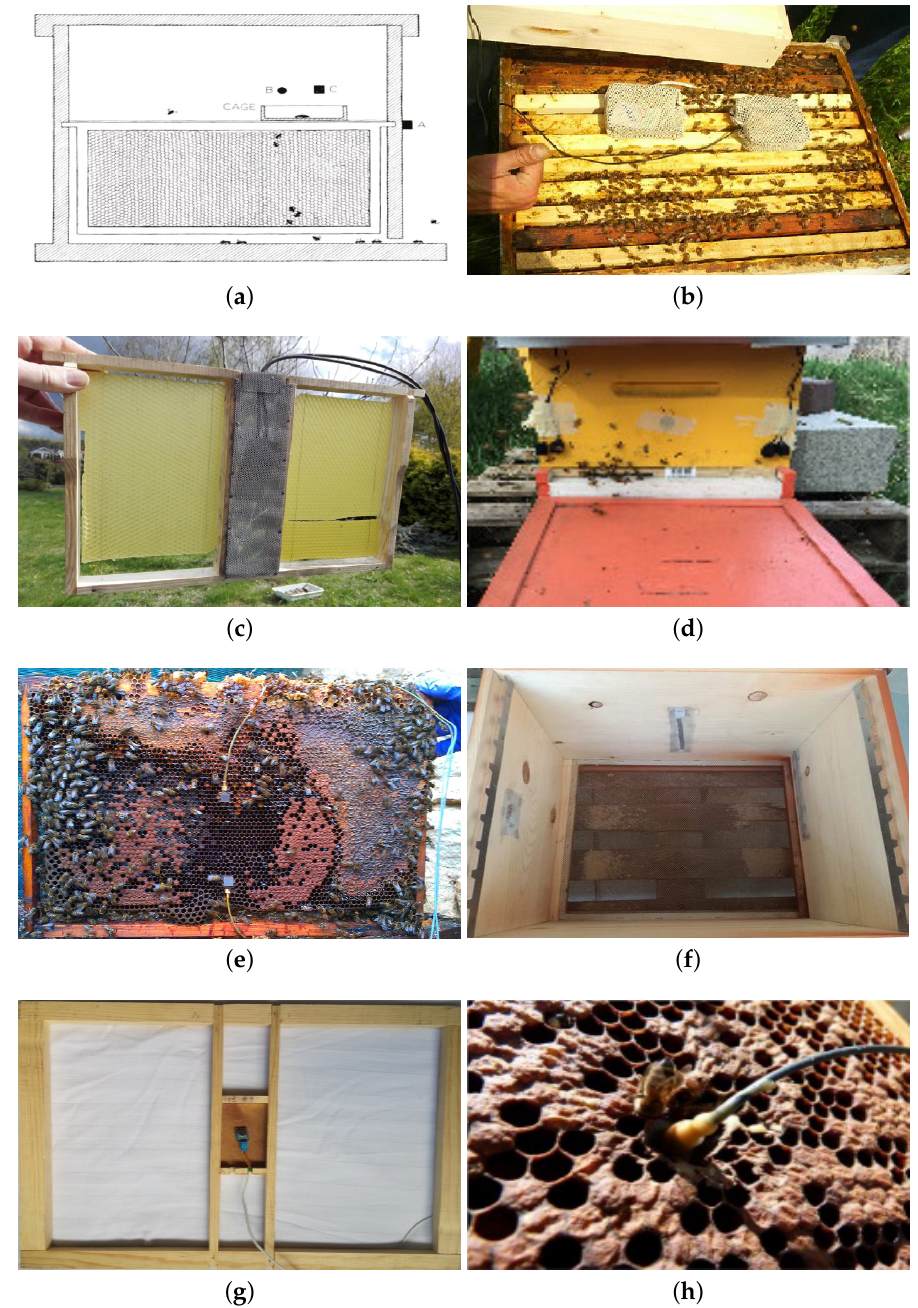
Figure 2. Different microphones and accelerometers placement inside the colonies, based on different approaches. In particular: in ( a ) from [27], B is the microphone used and it is placed above the queen cage. ( b ) shows the microphone placement of [63]: the sensors are placed upon the brood frames inside a cage to protect them from propolization. ( c ) shows the solution adopted in [45], where a custom frame with the sensors inside has been chosen. ( d ) refers to the approach proposed in [44], with microphones placed outside the hive, so that a cage to protect against propolization is not necessary. In ( e ), accelerometers placement proposed in [43] is presented: the sensors exploit vibrations and do not suffer from propolization problems. ( f ) belongs to approaches presented in [51,52,57,58]: the microphones are hidden inside the hive walls, and a grid is used to protect them. ( g ) from [54] shows a custom brood frame. Finally, ( h ) from [61] shows accelerometers positioning similar to the one proposed in